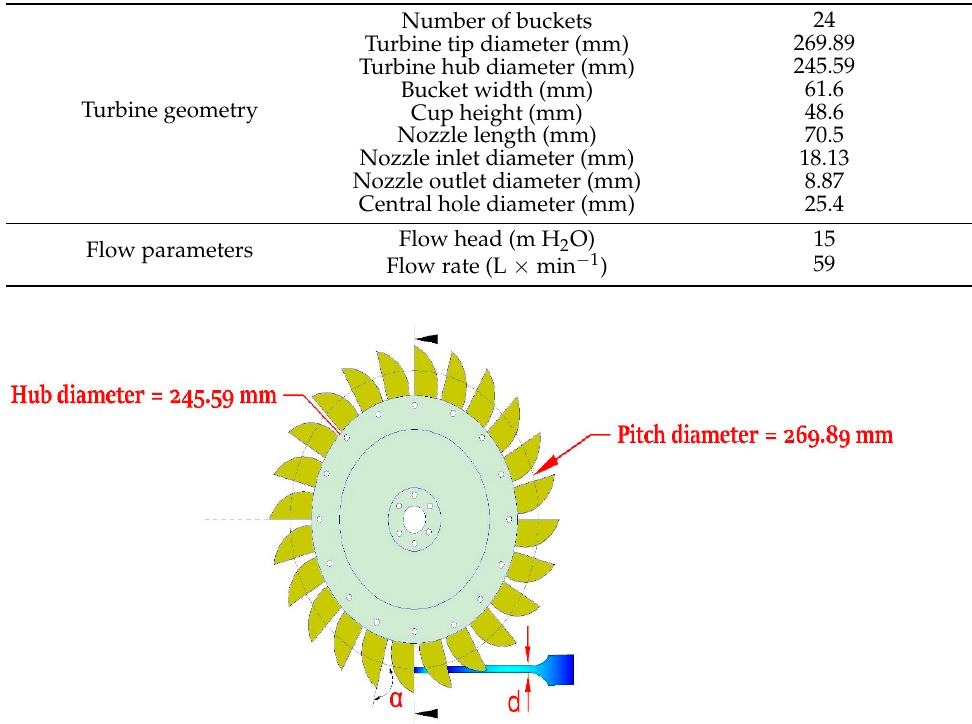
Figure 2. Pelton turbine geometry.